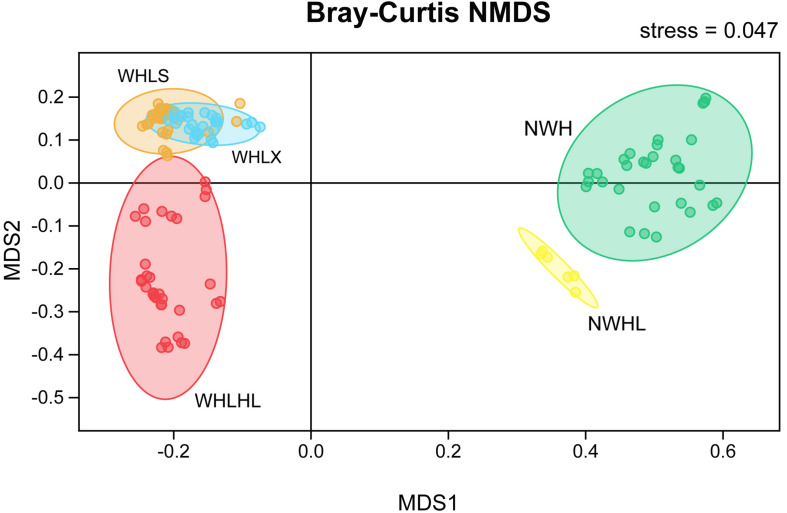
Non-metric multidimensional scaling (NMDS) ordination plot based on the Bray–Curtis dissimilarity data. Different colors represent different groups. Abbreviations: WHLS, lake water from the upper part of the lake; WHLX, lake water from the lower part of the lake; WHLHL, tributary water; NWH, sediment lake; NWHL, sediment tributary.